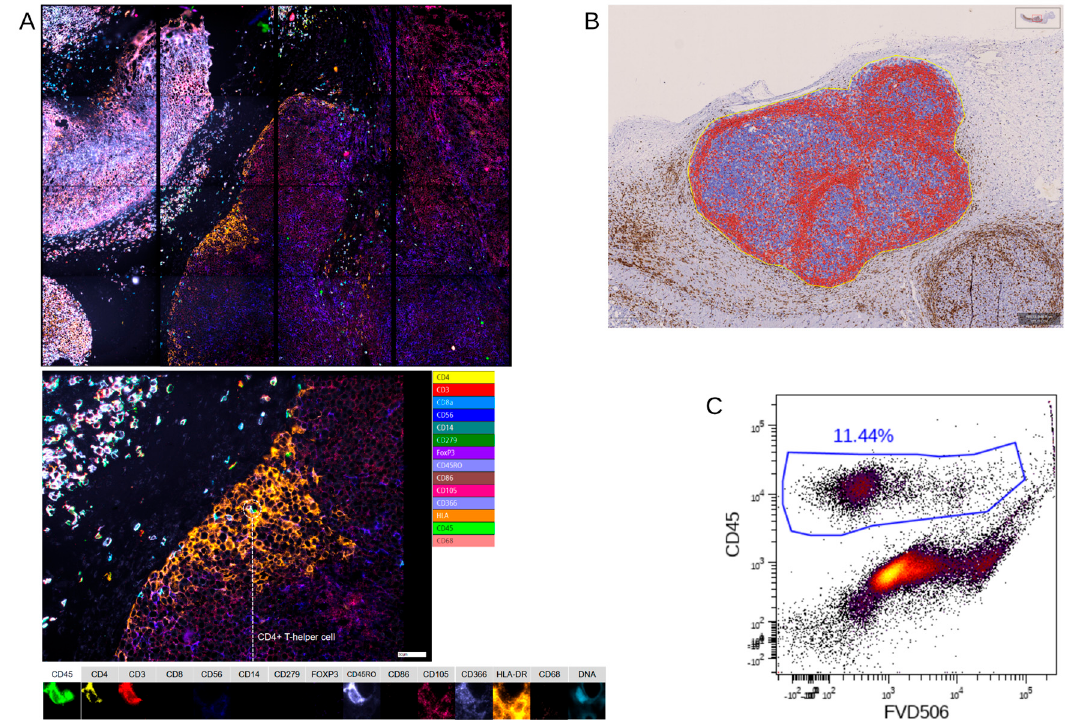
Figure 3. Multimarker analysis of the whole tumor, as well as a single cell in Chipcytometry ( A ), data analysis of CD45 + (positive cells in red, negative cells in blue) cells in immunohistochemistry ( B ), and gating for all CD45+ against a live/dead stain, human immune cells in flow cytometry ( C ). One typical experiment is shown.